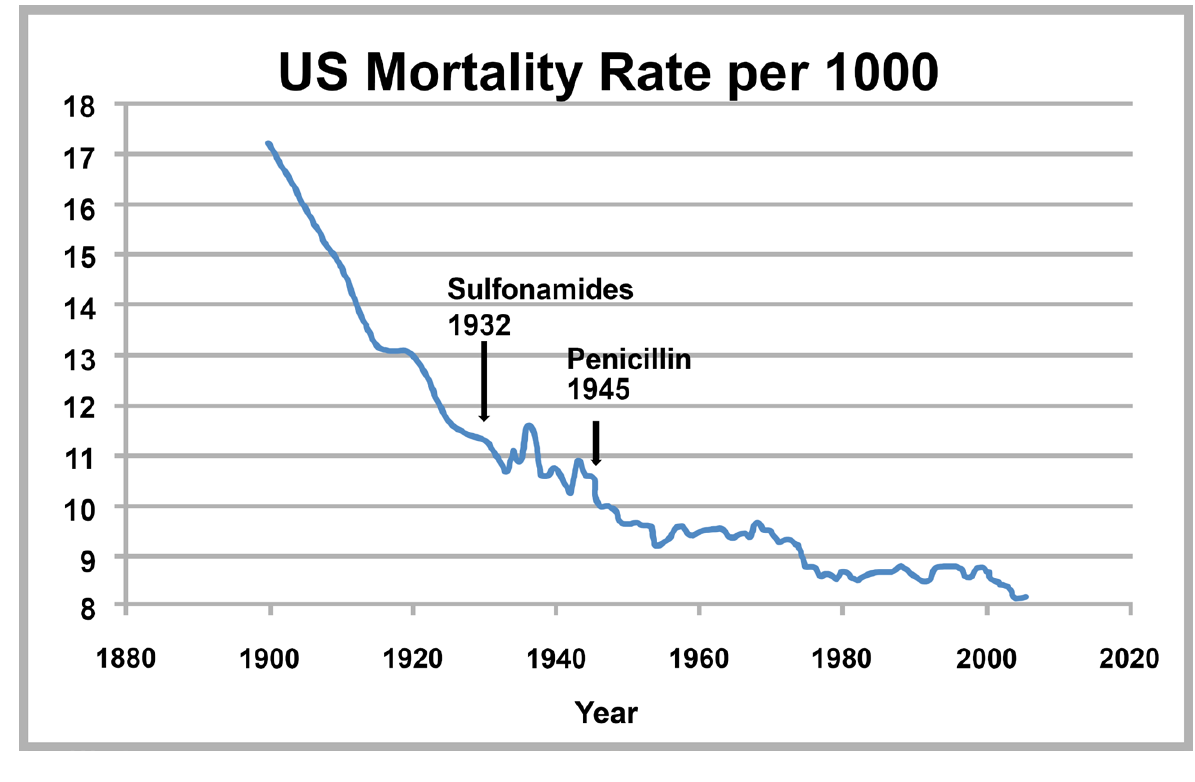
Figure 3. US Infectious Disease Mortality [ 10